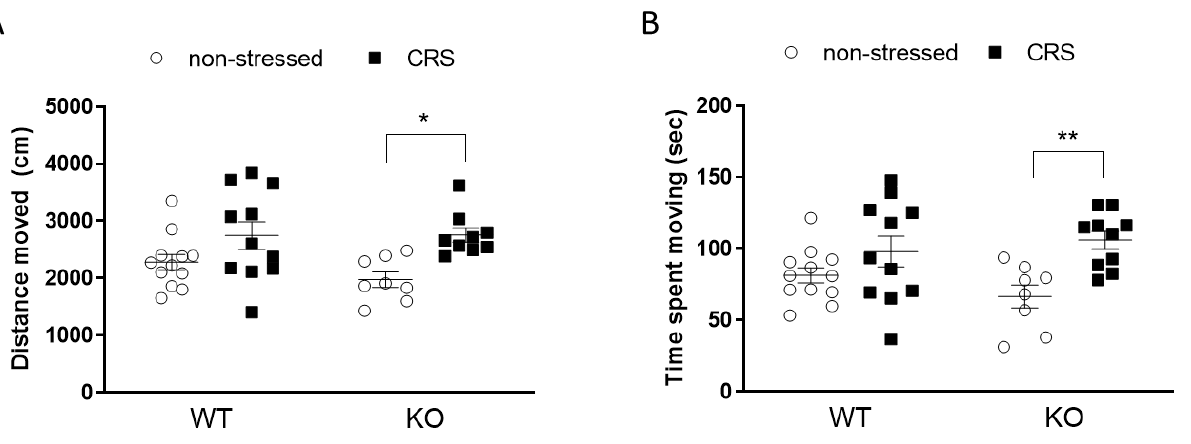
Figure 6. Behavioral alterations induced by chronic restraint stress (CRS) in wild-type (WT) and Interleukine-1 knock-out (KO) female mice detected with an open field test (OFT). The distance moved ( A ) and the time spent on moving ( B ) in the OFT. Data are presented as the means ± SEM of n = 8–12 animals with individual plots; two-way analysis of variance (ANOVA), followed by Tukey’s tests; * p < 0.05, ** p < 0.01 vs. own control group.